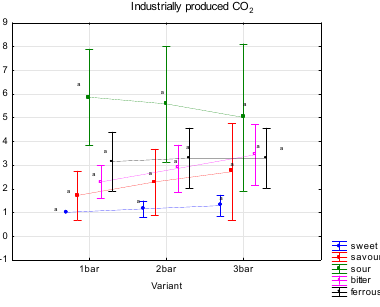
Figure 4. Results of sensory analysis of aromatic profile of saturated waters using fermentation gases captured from grape must fermentation and industrial CO 2 . The division into homogeneous groups (a,ab) was based on the LSD test, the significance level is α = 0.005.